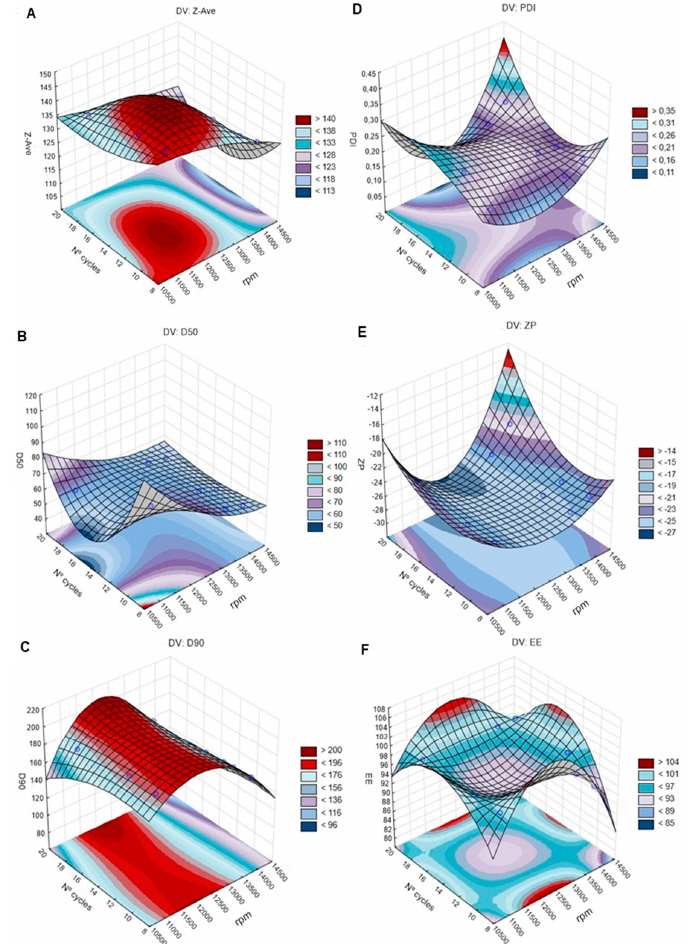
Figure 2. The 3-D surface plots portraying the effects of the number of high- pressure homogenization (HPH) cycles and emulsification speed (rpm) on the size (Z-Ave (mean particle size); D50 (50% of particles with size equal or lower to the given value) and D90 (90% of particles with size equal or lower to the given value)) (left: A – C ), polydispersity index (PDI), zeta potential (ZP), and encapsulation efficiency (EE) (right: D – F ).